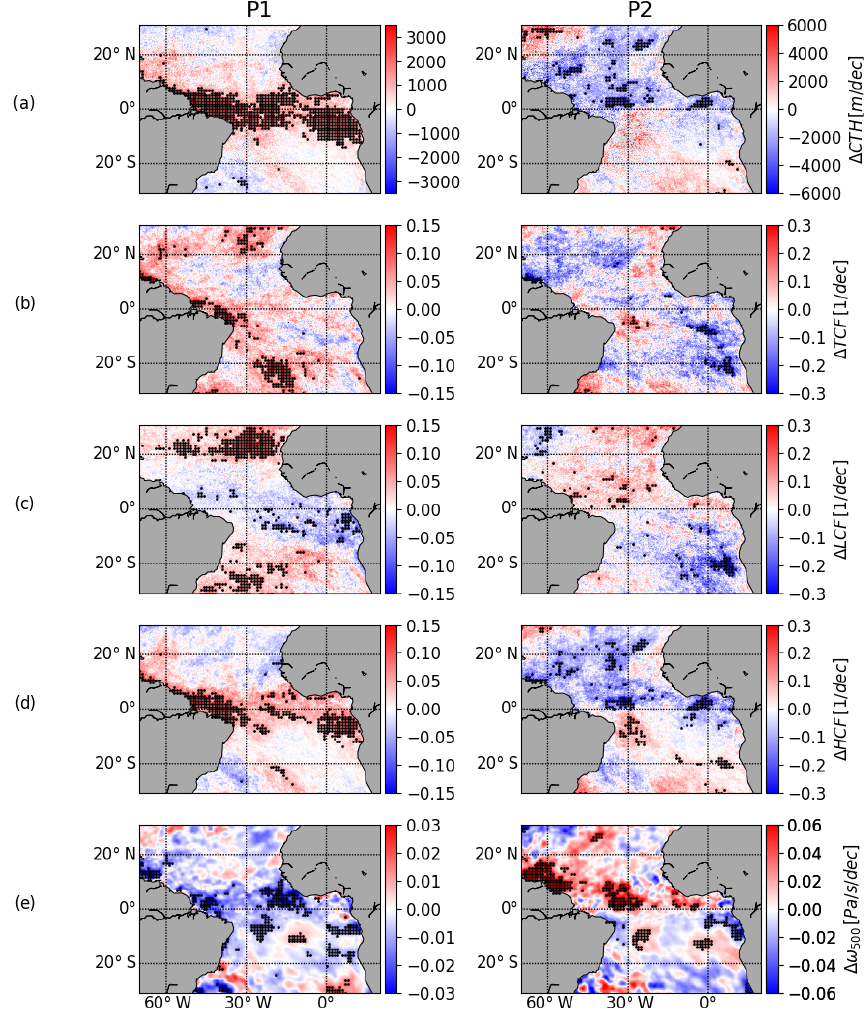
Figure 6. Temporal linear changes of CTH, TCF, HCF, and LCF for every 0.2 ◦ × 0.2 ◦ grid box. On the left are the temporal linear changes for phase 1 and on the right are temporal linear changes for phase 2. The dots indicate that within a grid box of 1 ◦ × 1 ◦ , more than half of the temporal linear changes were statistically